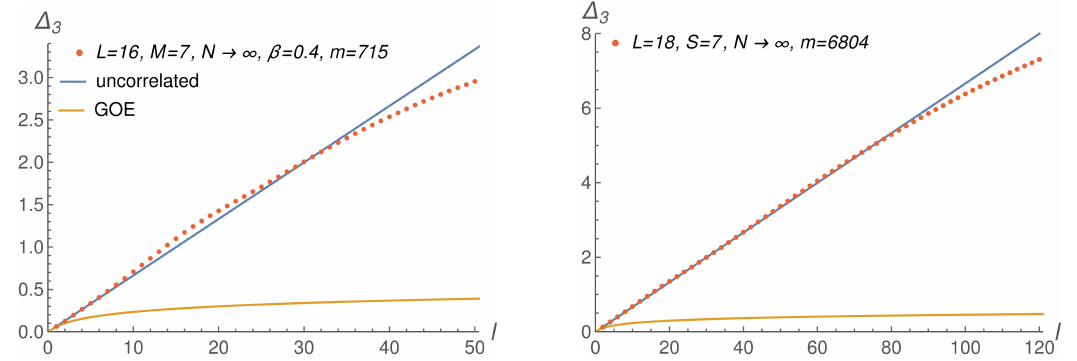
Figure 6: On the left we plot ∆ for the planar β -deformed theory in the su ( 2 ) sector. 3 The single-trace sector contains only 715 states, which could justify the deviation to the expected behaviour. On the right we plot ∆ in the sl ( 2 ) sector of planar N = 4 3 SYM, where integrability allows us to find the spectrum exactly. There we have 6804 states and the result matches the linear behaviour all the way up to l ≈